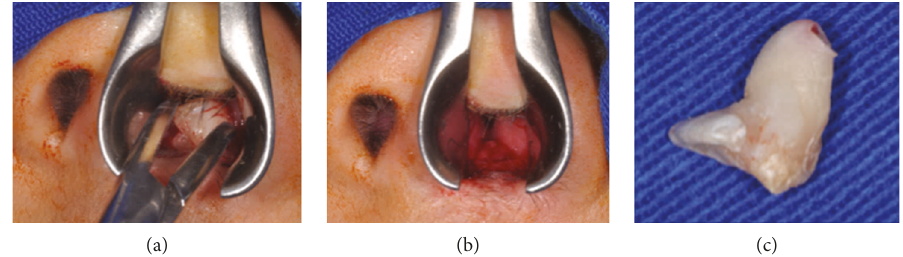
Figure 4: (a) Nasal speculum provided direct access to the toothlike structure removal with a Kelly hemostatic forceps. (b) Hemostasis obtained after the toothlike structure has been removed. No stiches were needed. (c) Ectopic tooth